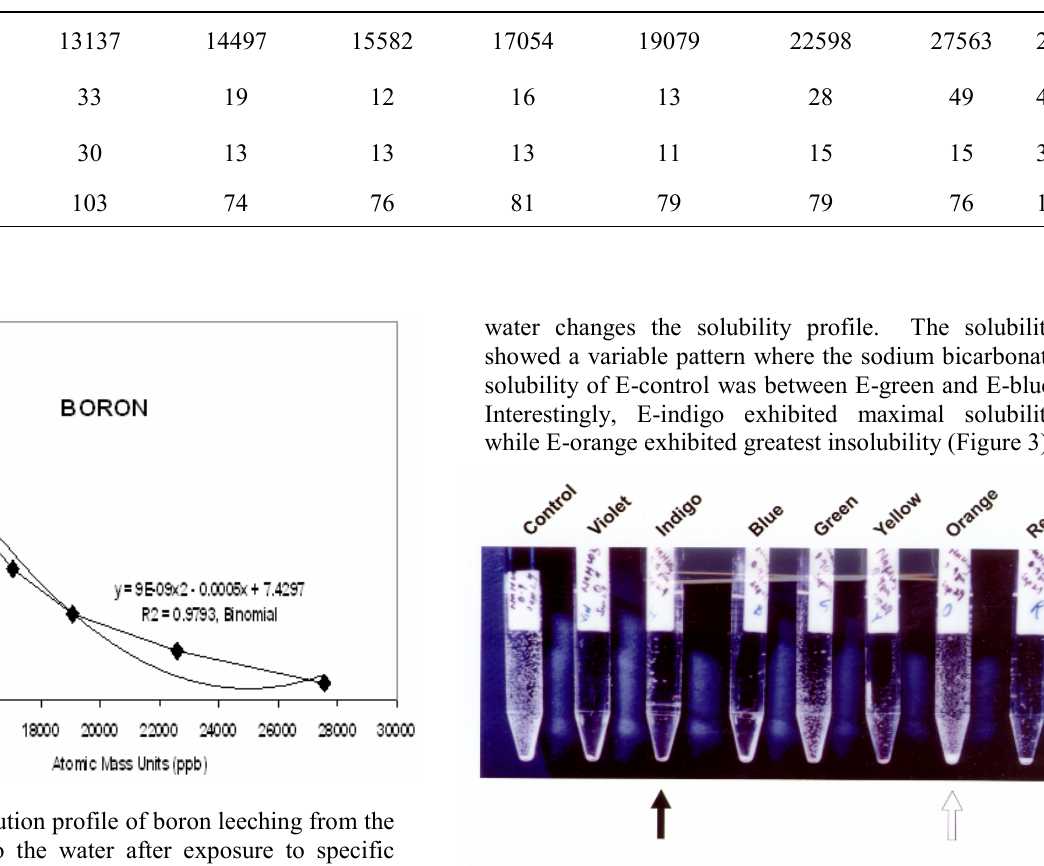
Figure 3: Each tube contains 1.0 gram of sodium bicarbonate with different E-water. Macroscopic evaluation exhibits maximum solubility with E-I and maximal insolubility with